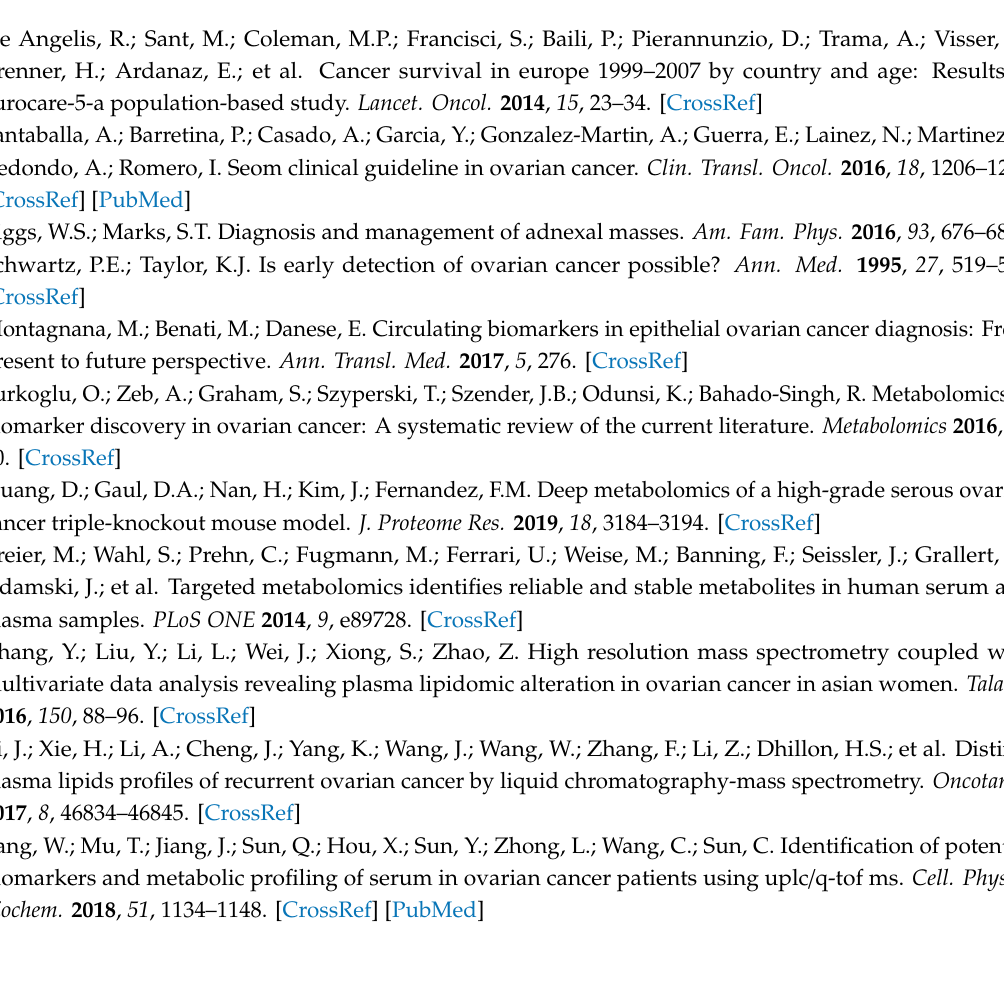
Figure S1: The total ion chromatogram and MS spectra of plasma phospholipids, Figure S2: The MS / MS / MS spectra of SM (d18:1 / 16:0) and SM (d18:2 / 18:0), Figure S3: Changes in the ratio of phospholipids depending on sample amount, Figure S4: Flow chart for study design and biomarker selection